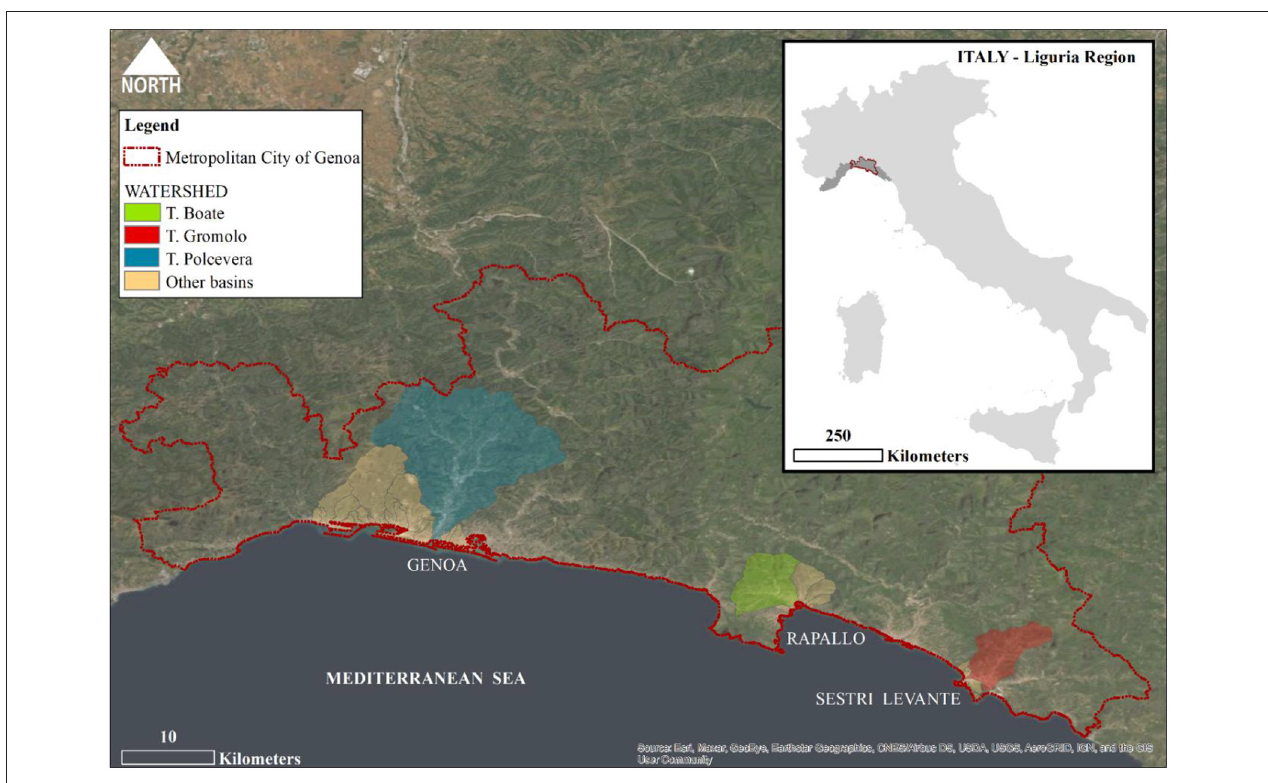
FIGURE 1 | Area of interest (source: